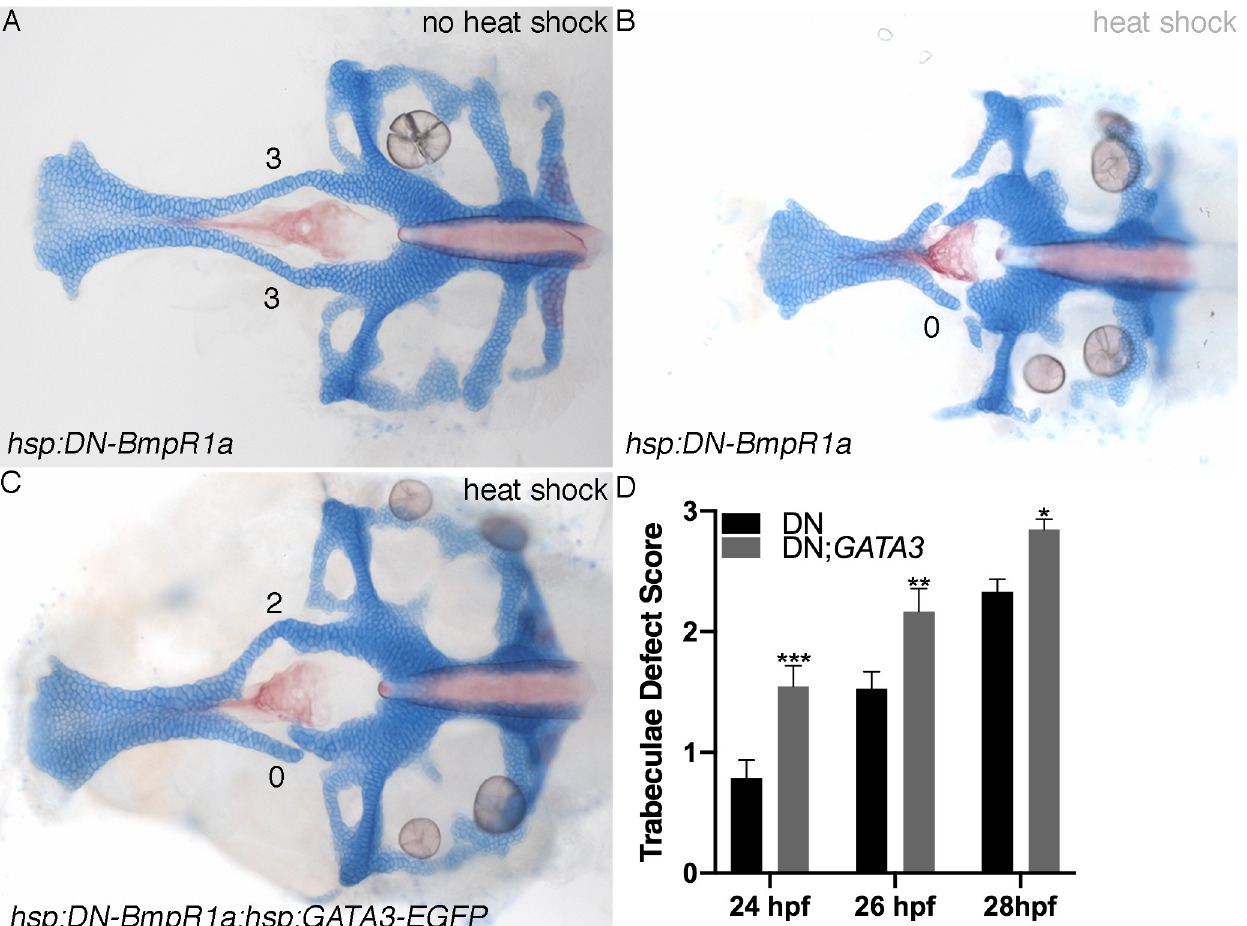
Fig 7. Gata3 functions downstream of Bmp in palate development. (A-C) Flat mounts of 4 dpf neurocrania anterior to the left. (A) Wild type phenotype of the hsp : DN-BmpR1a with no heat shock. (B) Severely affected trabeculae typical of the hsp : DN-BmpR1a when heat shocked at 24 hpf. (C) A typical rescue of the hsp : DN-BmpR1a;hsp : GATA3-EGFP heat shock phenotype at 24 hpf. (D) Graph depicting quantification of heat shock phenotype scores at three different heat shock time points. Trabeculae phenotype is rescued significantly by hsp : GATA3-EGFP at 24 and 26 hpf. Phenotypes are also rescued at 28 hpf, but to a lesser degree as the overall phenotype is not as severe. A two way ANOVA was performed with Holm-Sidak’s multiple comparisons test. At all heat shock timepoints the hsp : DN-BmpR1a controls had significantly worse phenotype when compared to the hsp : DN-BmpR1a;hsp : GATA3-EGFP double heat shock.